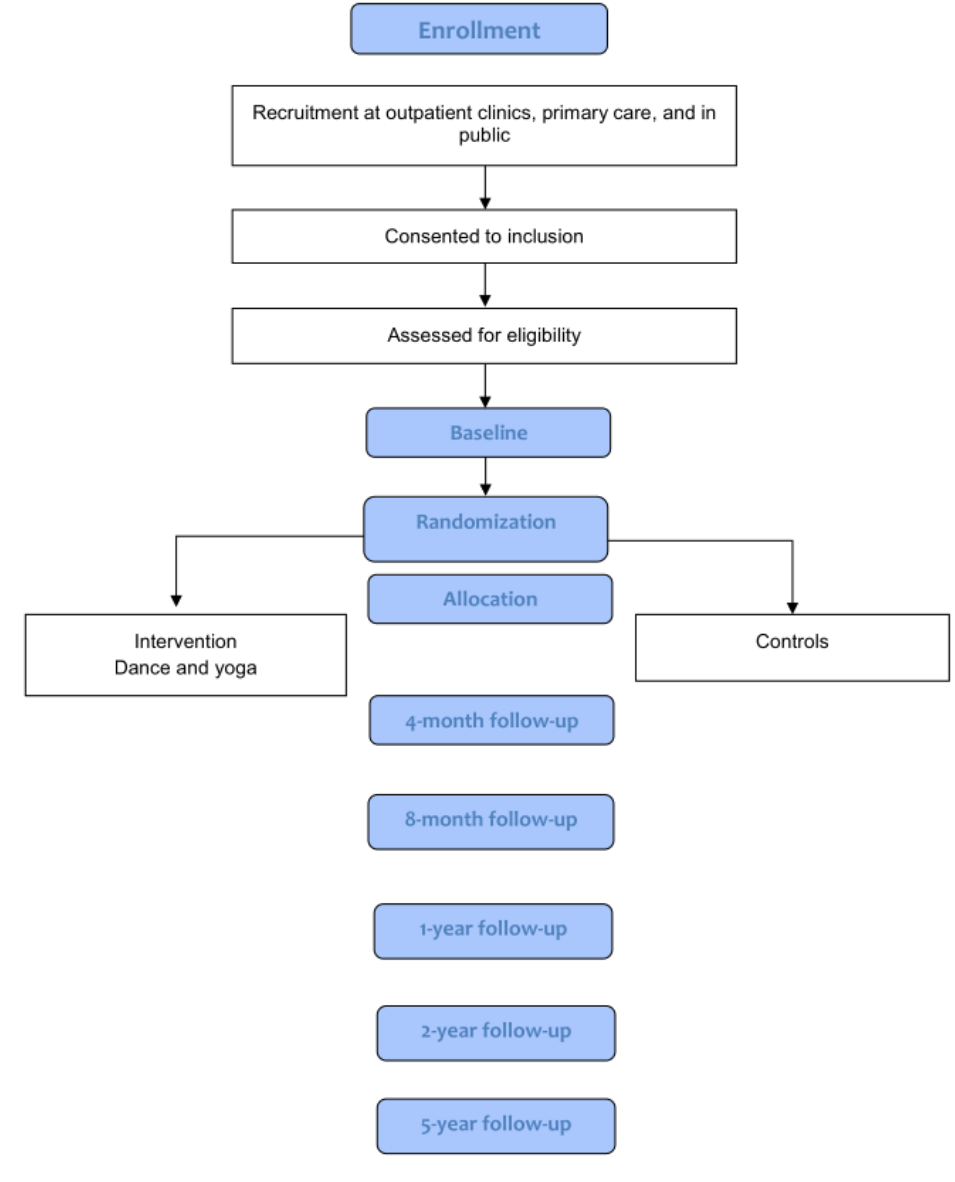
Figure 1. Flowchart of the